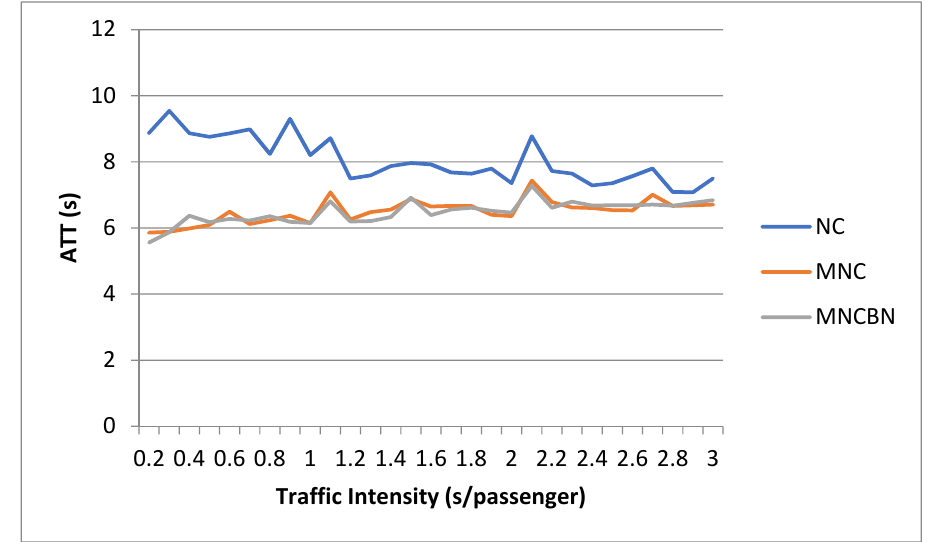
ffi c intensity.